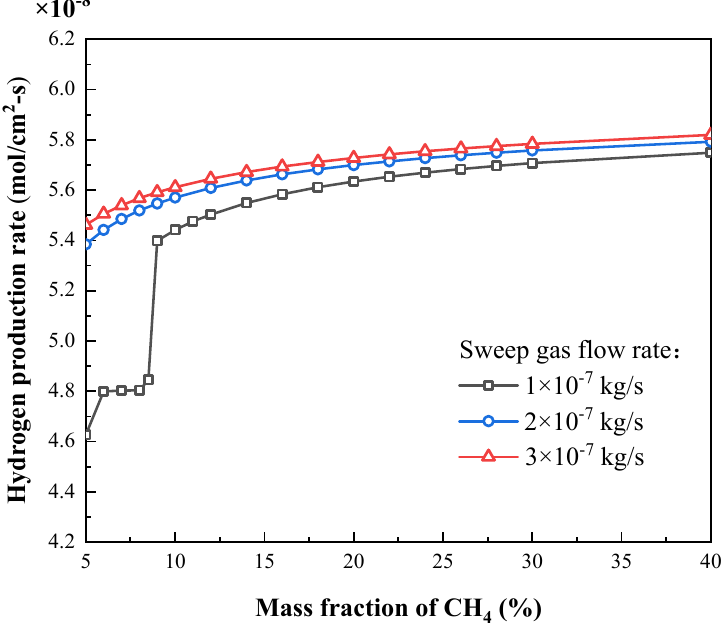
Figure 12. Hydrogen production rate at different sweep gas flow rates and methane contents.